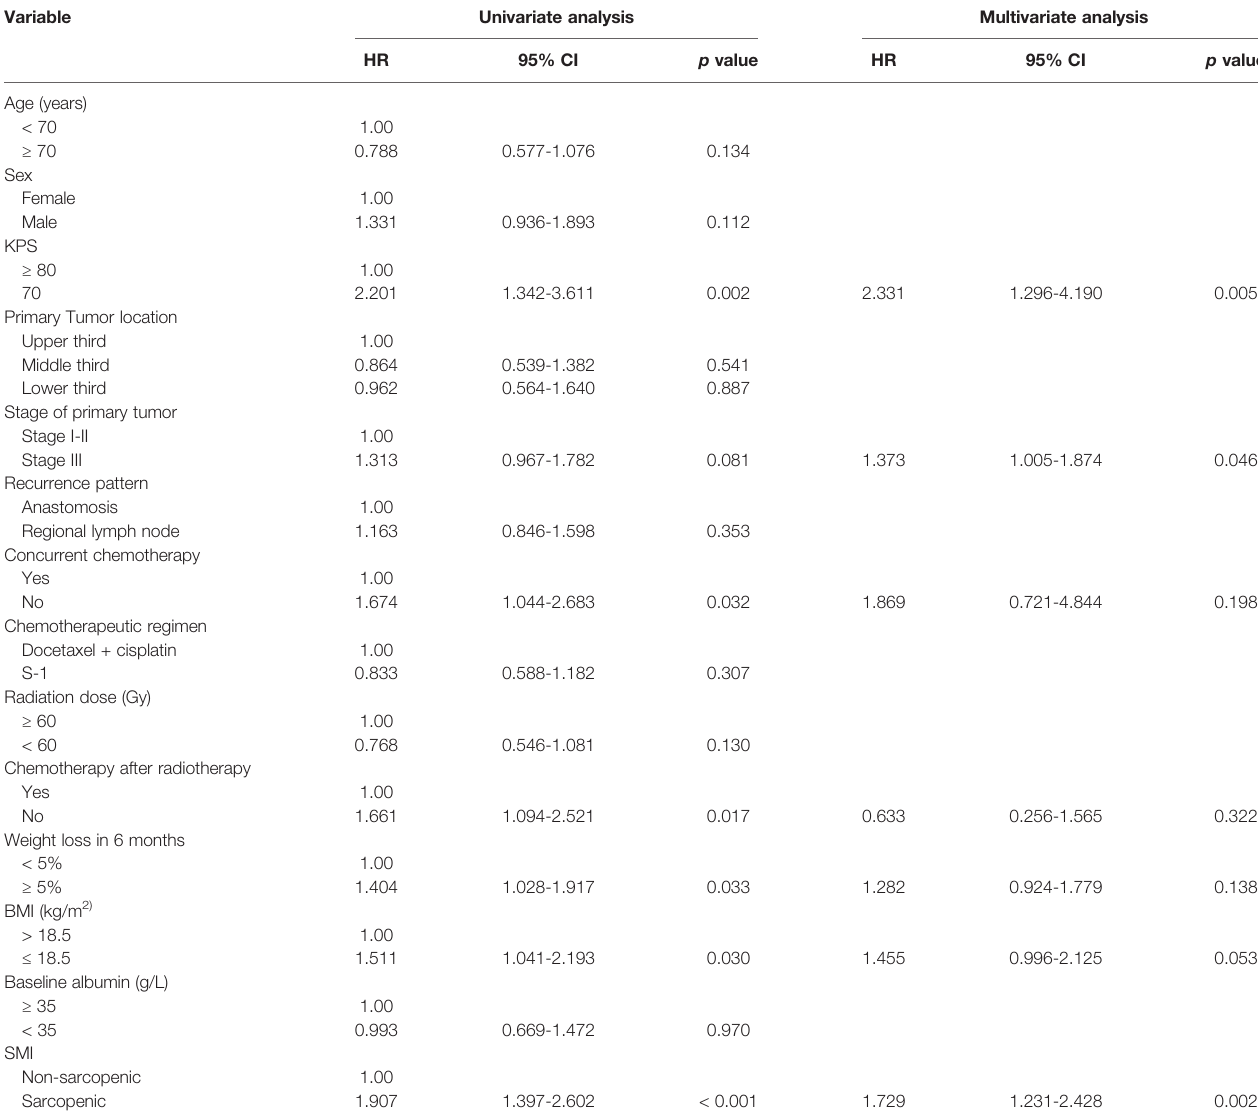
TABLE 4 | Univariate and multivariate cox regression analysis for predictors of overall survival.